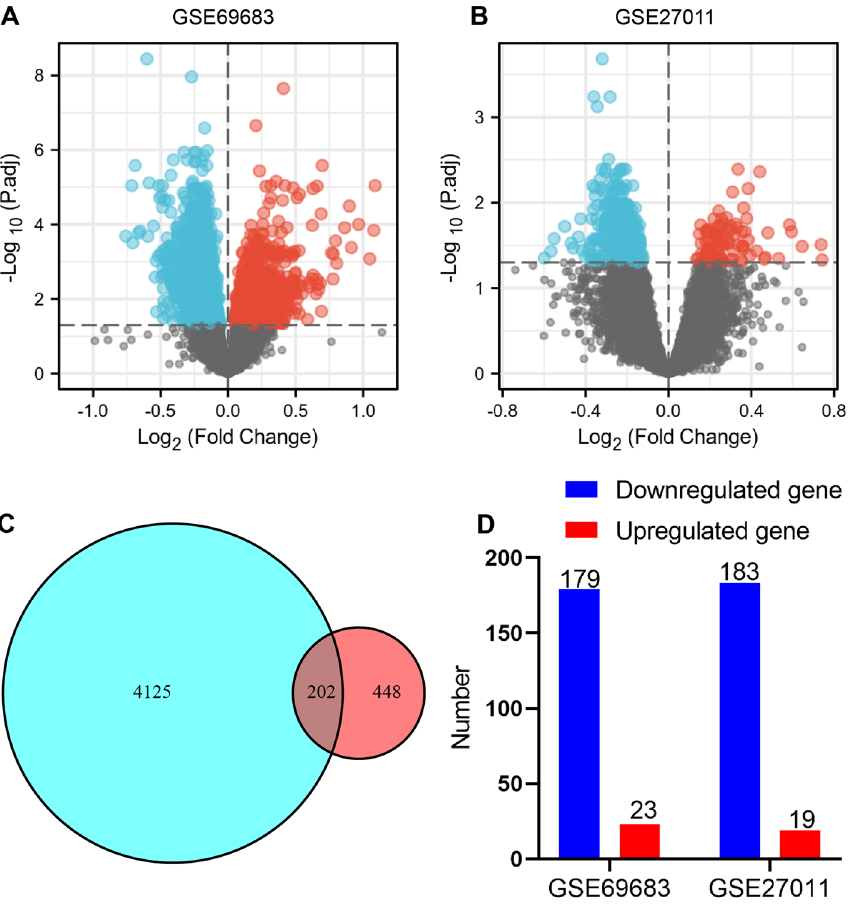
Figure 1. Identification of DEGs. The volcano plot for GSE69683 ( A ) and GSE27011 ( B ). Red dots represent upregulated genes; blue dots represent downregulated genes; grey dots represent genes with no significant expression differences. ( C ) Venn diagram for GSE69683 (the blue set) and GSE27011 (the red set). ( D ) The number of upregulated and downregulated genes of shared 202 genes in GSE69683 and GSE27011,